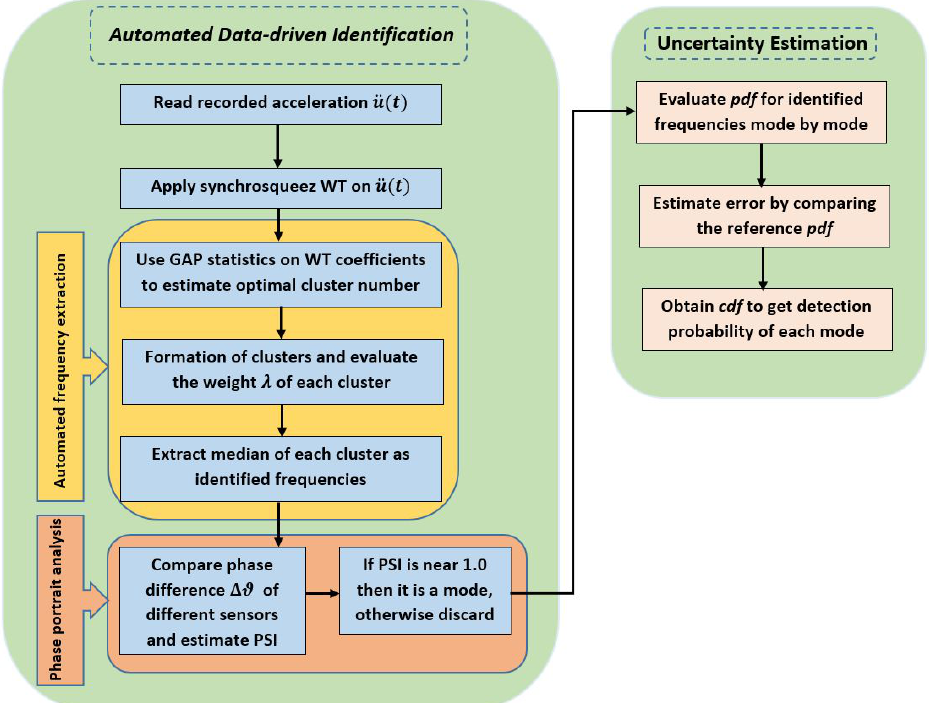
Figure 1. Proposed automated data-driven